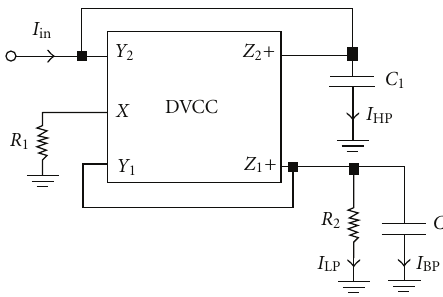
Figure 3: Proposed current-mode biquad